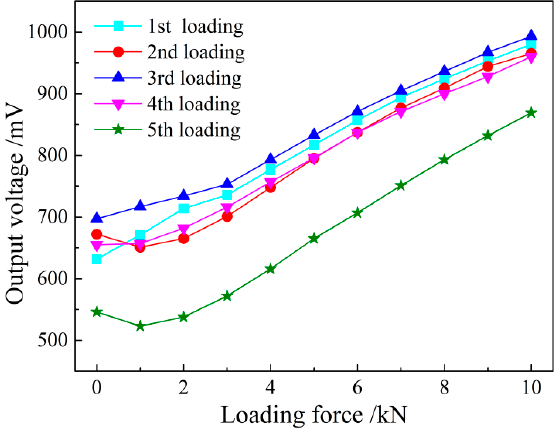
Figure 14. The output voltage with loaded stress without magnetic shielding.